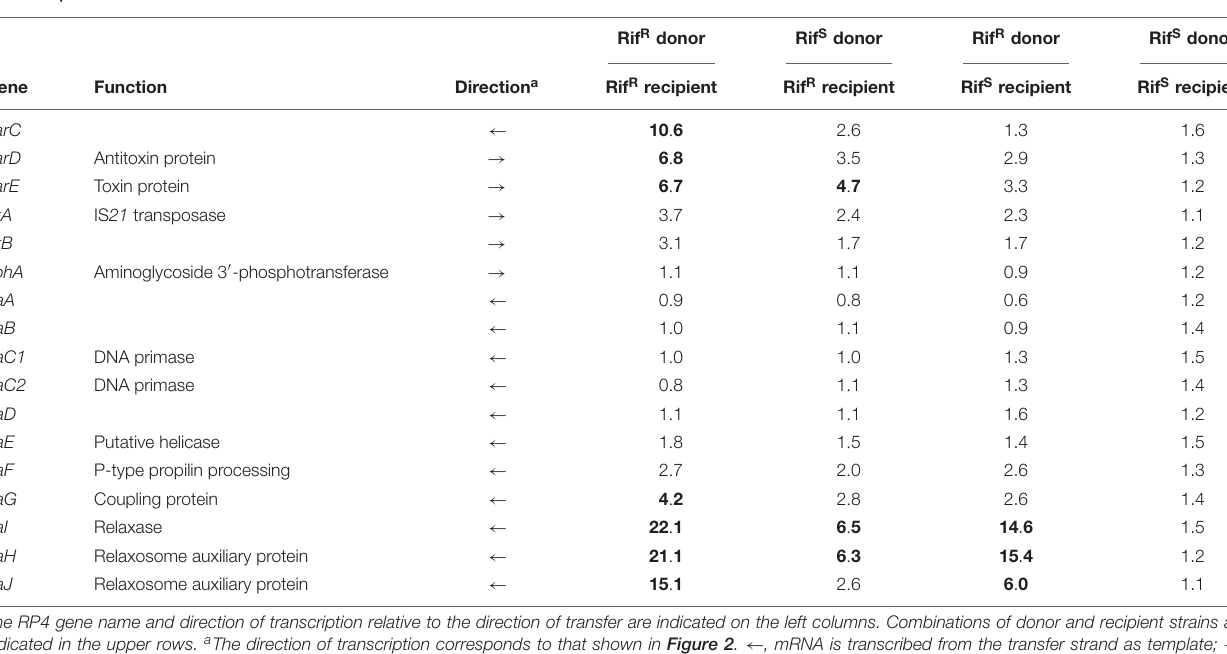
exhibit significant changes in common in our microarray data (data not